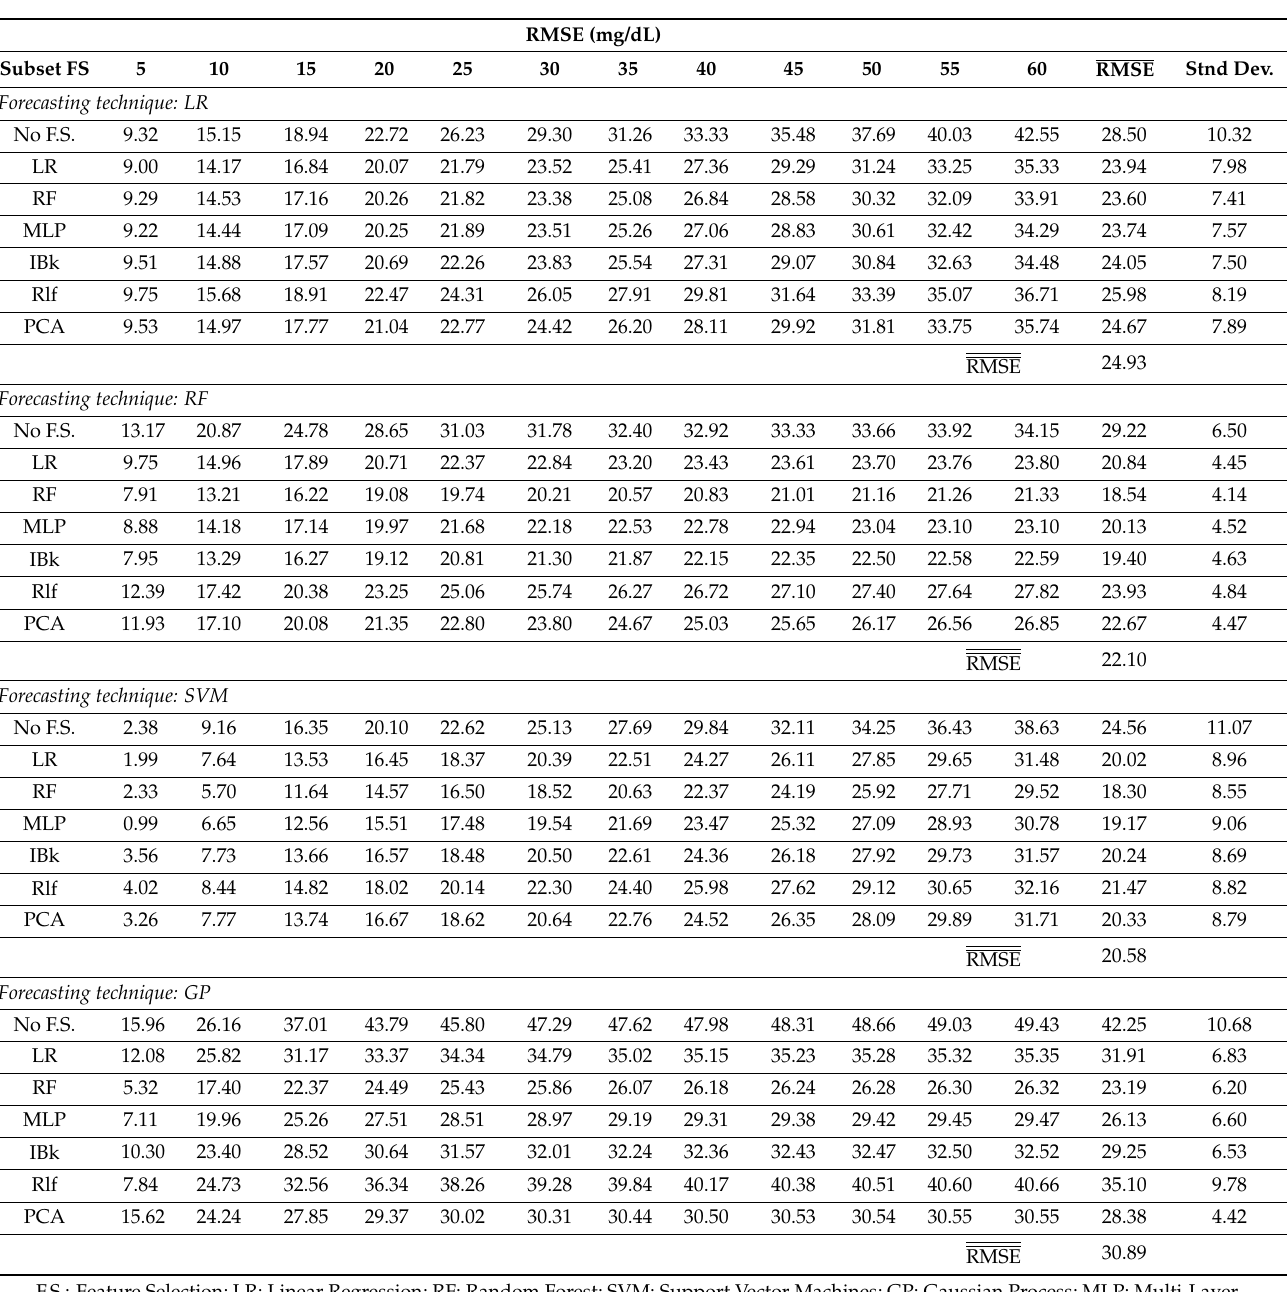
Table 5. RMSE in test stage up to 12-steps glycemia forecasting. Averaged results of 25